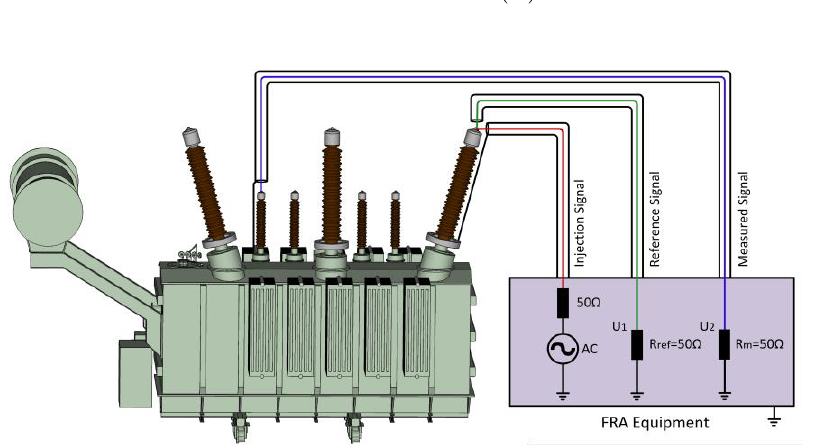
Figure 1. Frequency response analysis (FRA) measurement